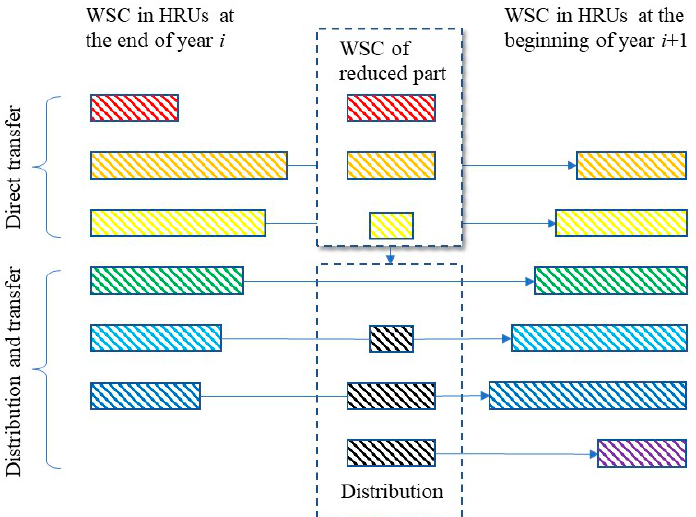
Figure 5. Schematic diagram of water storage component (WSC) transfer for HRUs in Figure 4. The length of the shadow bar represents the quantity of the WSC in the HRU, and the different color represents the WSC from the HRU of the corresponding color. The WSCs of reduced HRUs are initialized by the way of direct transfer from the end of year i to the beginning of year i + 1, but some of them have some water left because of the reduced area (reduced part), which is accumulated and then distributed to the non-reduced HRUs (black shadow bar), and initialize the WSCs of these HRUs together with the existing water at the end of year i .